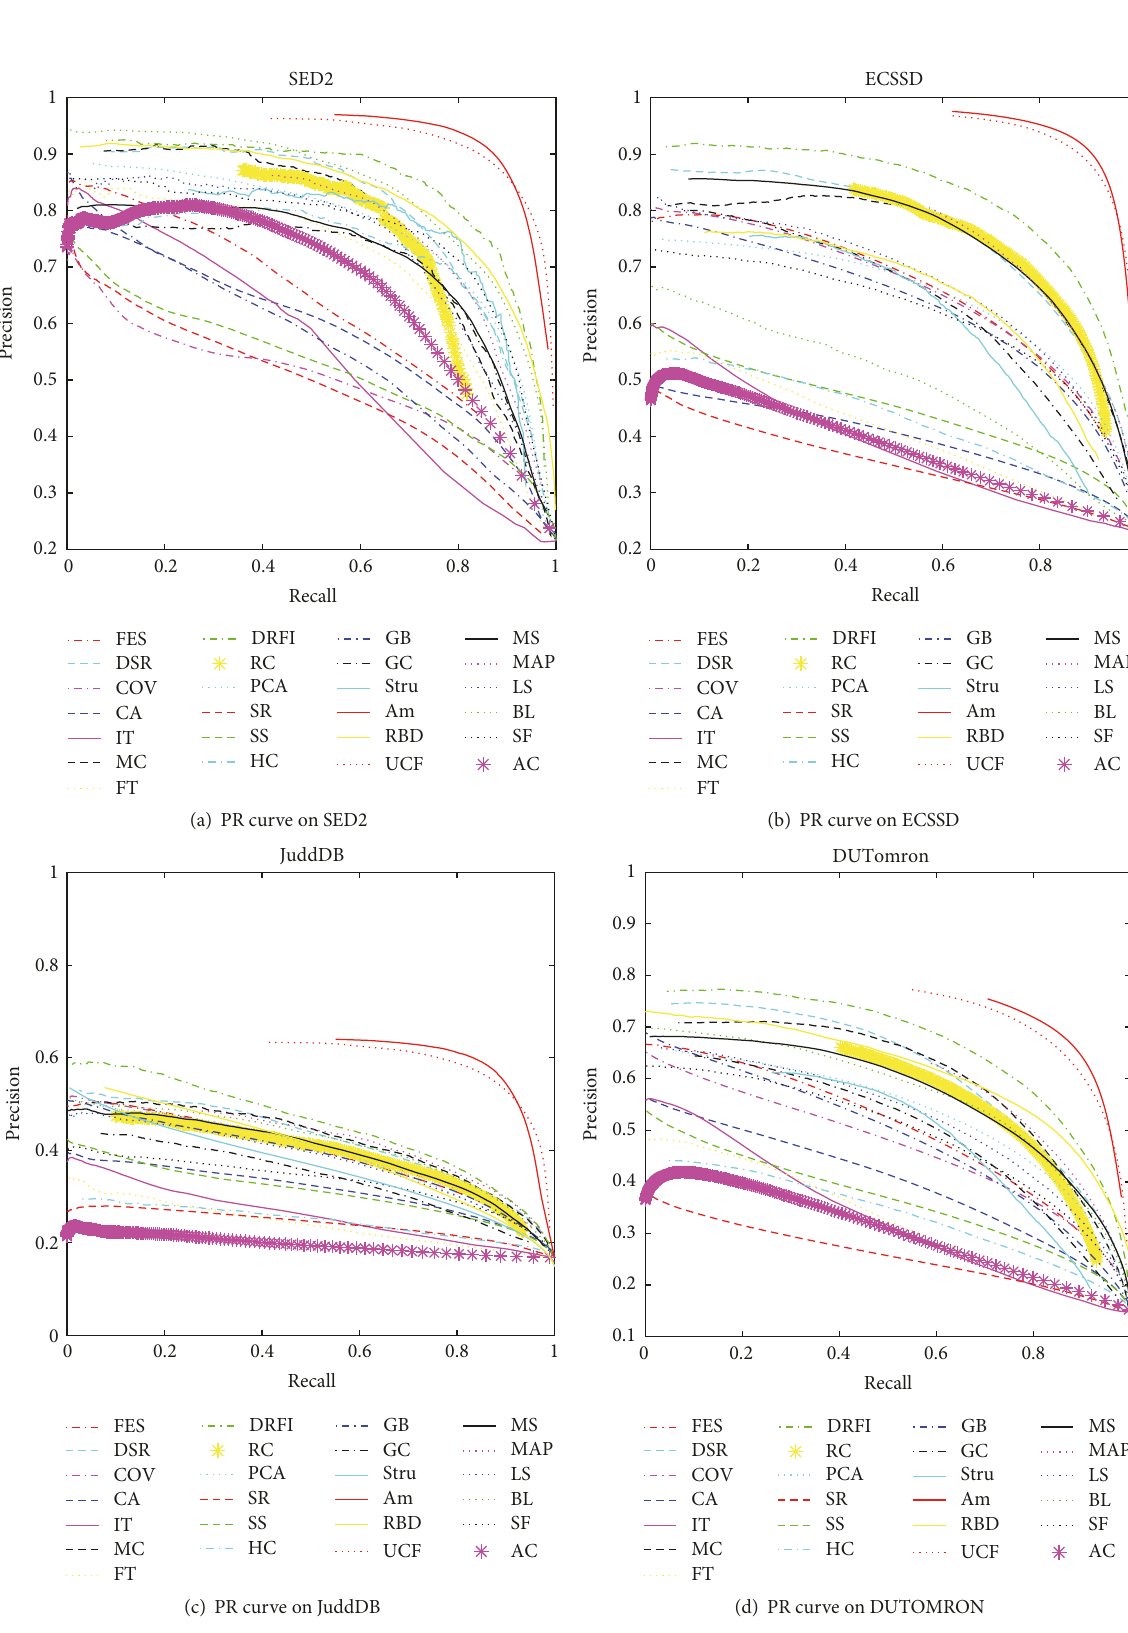
Figure 2: PR curves of the saliency models on each